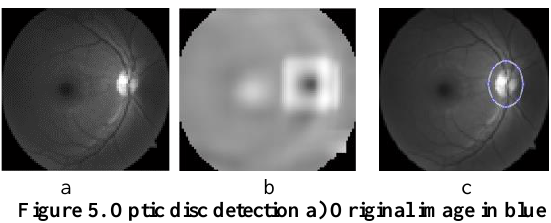
Figure 5. Optic disc detection a) Original image in blue channel, b) E matrix illustration, c) optic disk